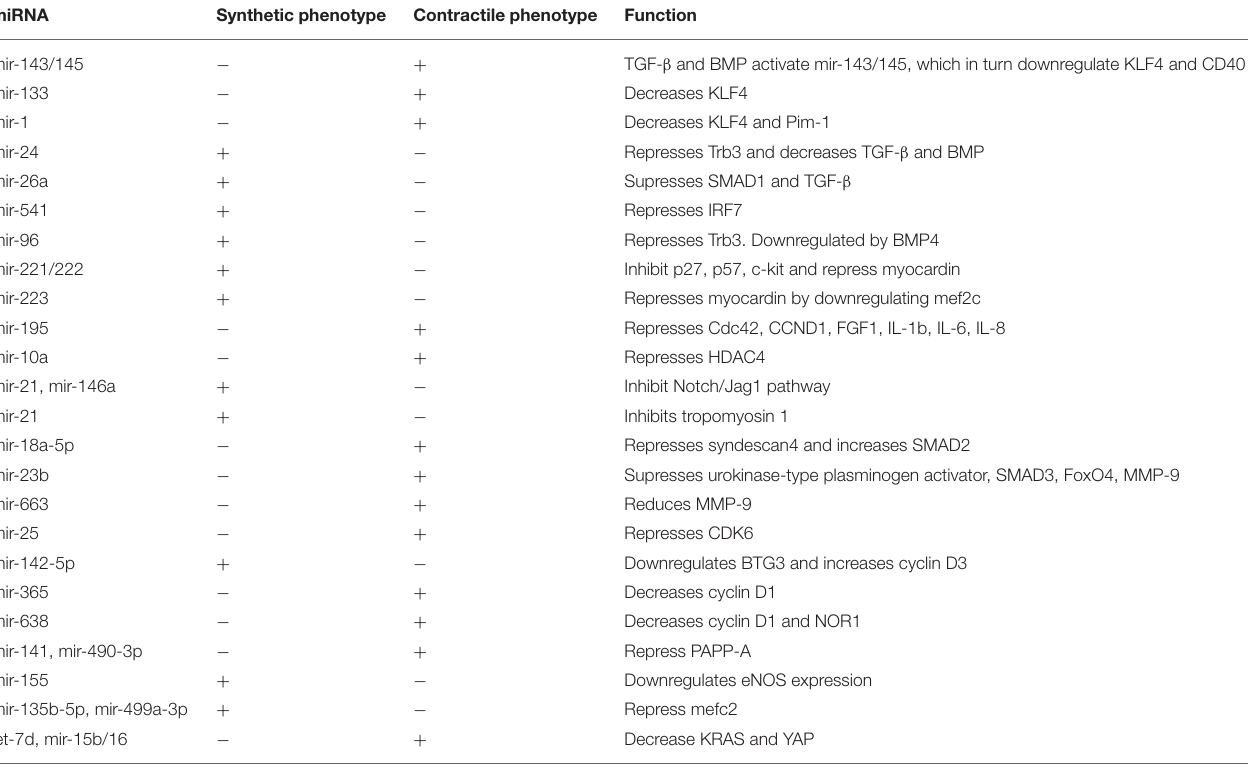
TABLE 2 | Role of miRNAs in VSMC phenotypic switch.